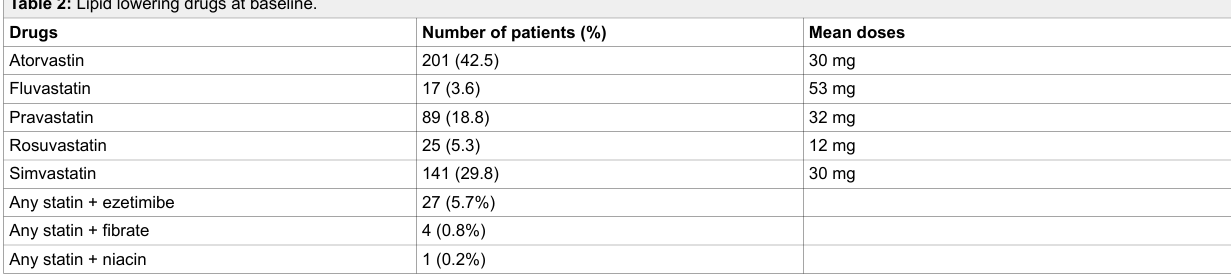
Table 2: Lipid lowering drugs at baseline.